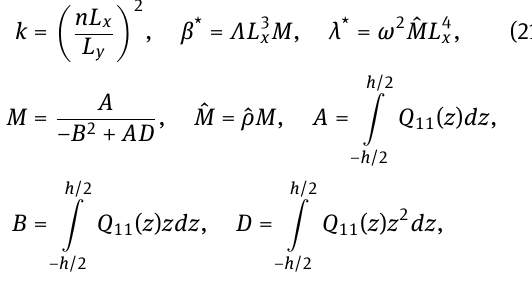
ρ m = 1200 kg/m 3